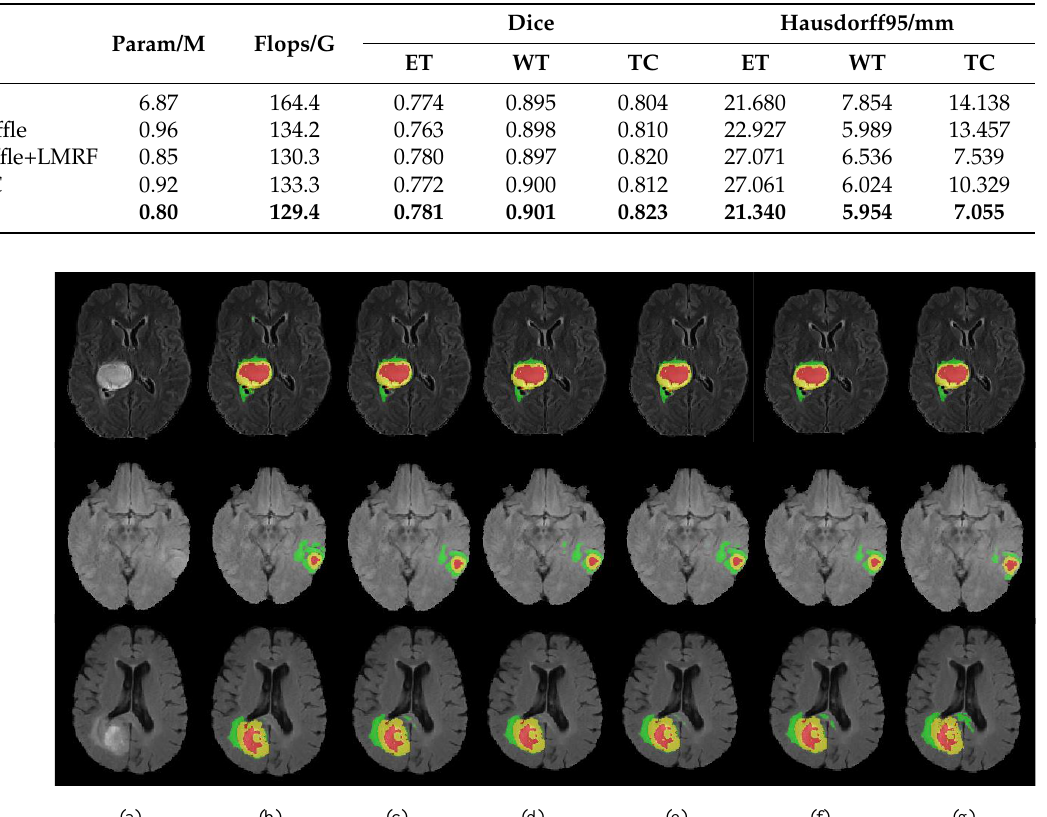
Table 8. The evaluation metrics for networks using different modules.